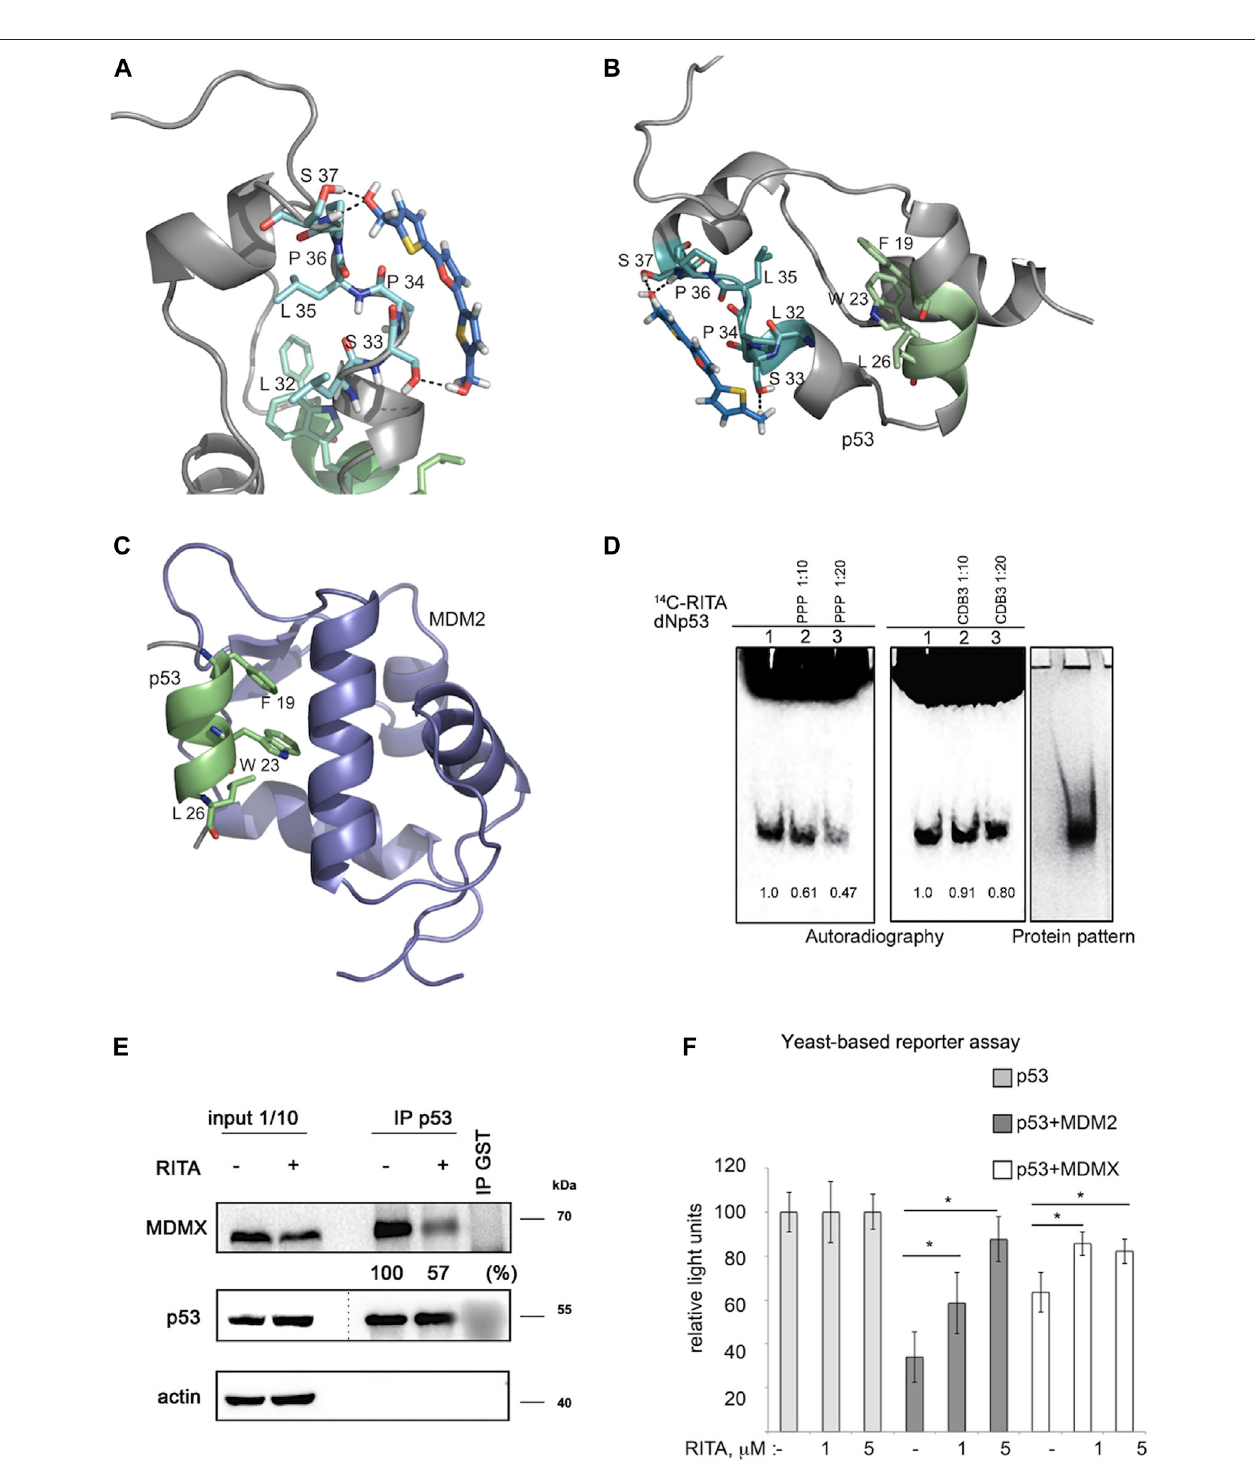
FIGURE 3 | Molecular modelling shows that RITA binds to S33 and S37, induces allosteric shift in Np53 and inhibits p53/MDM2 and p53/MDM4 interactions. (A) BindingofRITAtoSPLPSsequence(cyan)ofp53involvesinteractionwithS33andS37viaterminalhydroxylgroupsofRITA,andhydrophobicinteractionswithP34and P36. Hydrogen bonds are highlighted in black dotted lines. Orientation of the MDM2-binding helix of p53 ( lime ) is different upon p53 binding to RITA (blue) (B) and to MDM2 ( purple ) (pdb: 1YCQ) (C) . Side chains of residues (F 19 , W 23 and L 26 ) involved in MDM2 binding are shown in (B,C) . Atom type colouring; oxygen ( red ), nitrogen ( blue ), and sulphur ( yellow ). See also Supplementary Movie S1 . (D) . Proline triad competes for the binding to Np53 with [ 14 C]-RITA in gel shift assay as visualized by autoradiography. CDB3 peptide which binds to p53 core domain does not compete for the binding to Np53. Band density was measured using